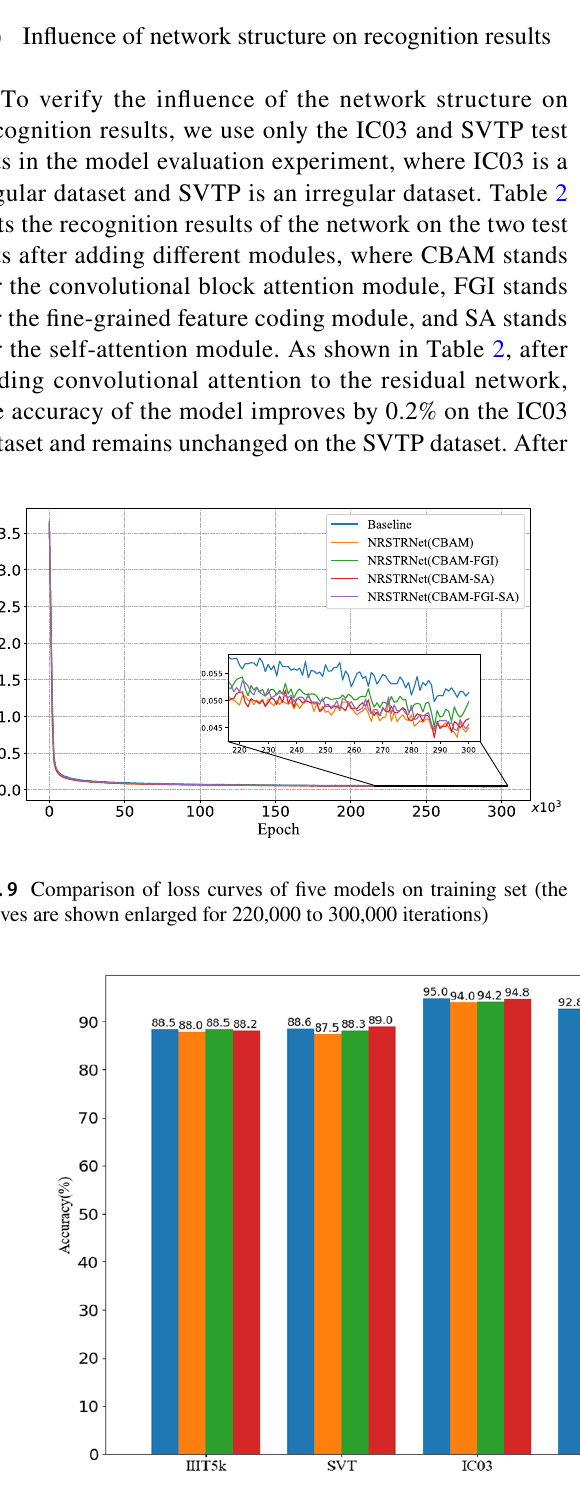
Fig. 10 Histogram of relationship between fine granularity and